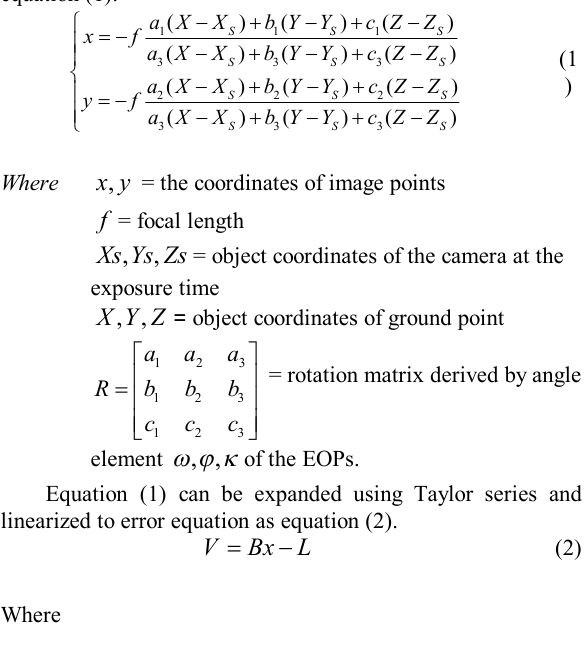
Due to the errors in the EOPs of digital images, the equation (4) can be modified to the error equation: